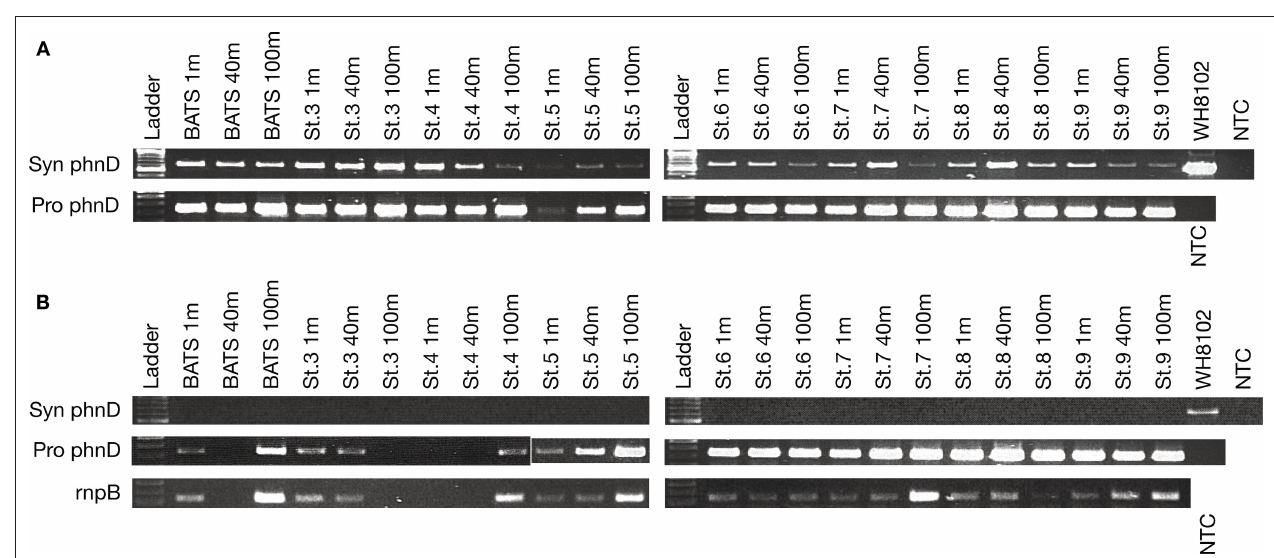
environmental RNA extracted from the same stations during the May cruise. (B) , bottom: RT-PCR of picocyanobacterial rnpB transcripts as a positive control for picocyanobacteria. NTC, no template control.